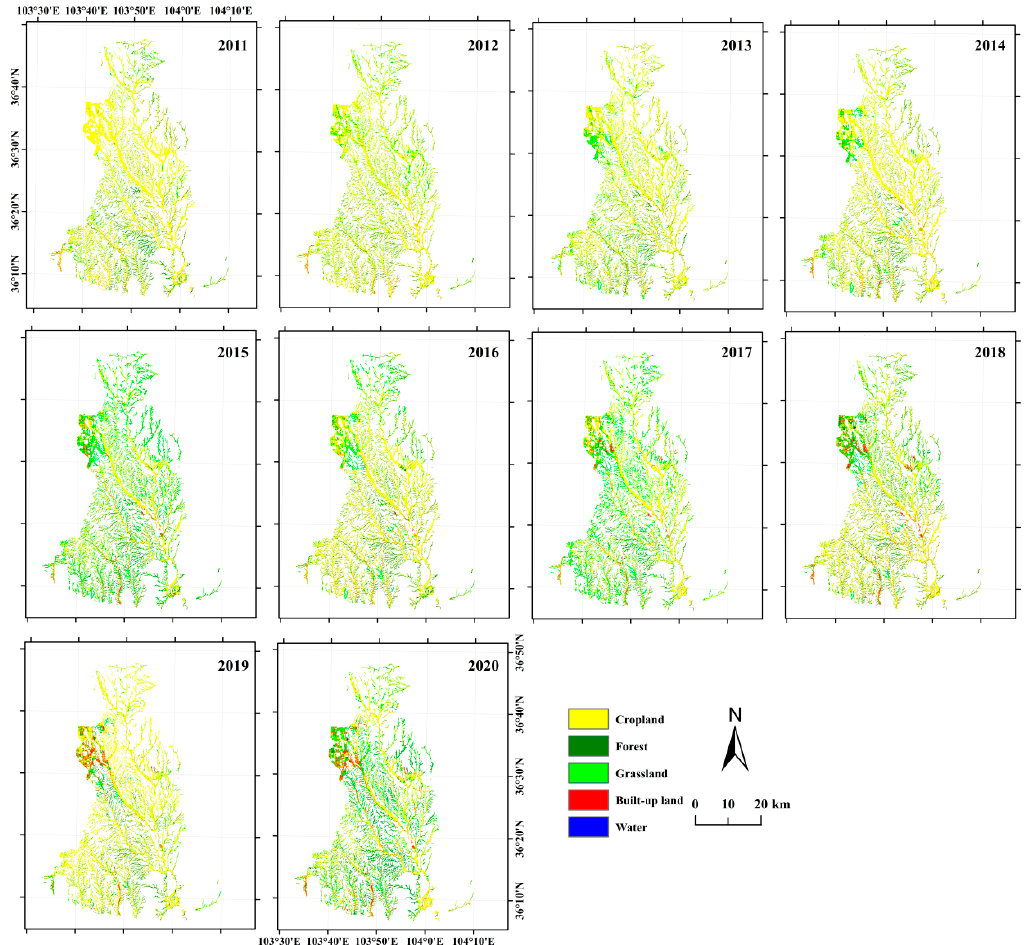
Figure 6. Results of land use classification in Gaolan County.